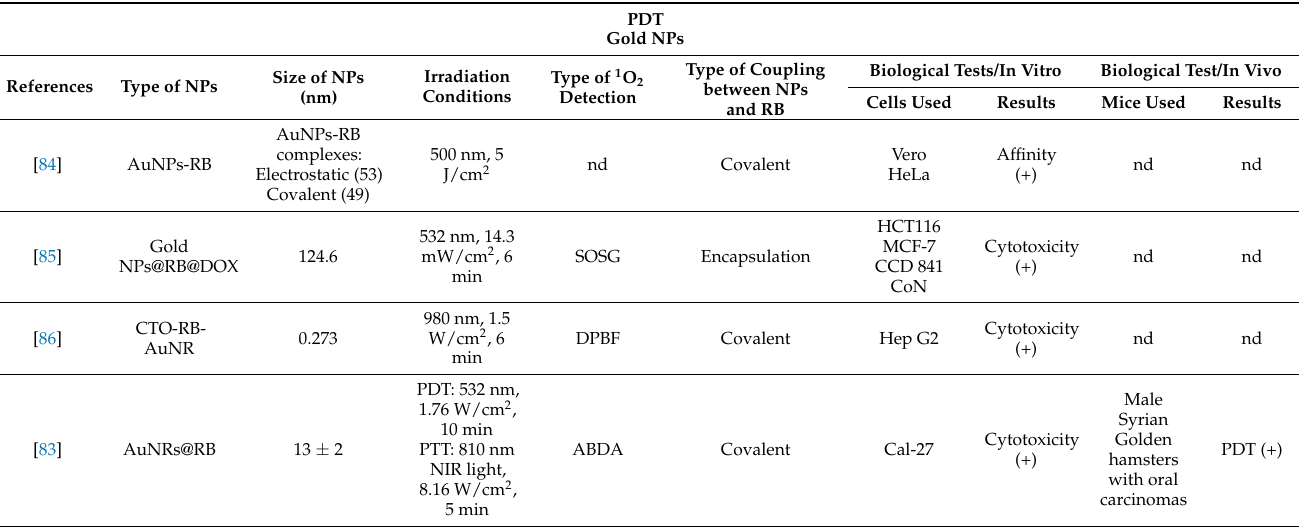
Table 4. References dealing with gold NPs@RB, including the type of NPs, along with their size, excitation wavelength, type of detection of 1 O 2 , the type of coupling between the NPs and the RB, and the type of biological experiments performed. PDT Gold